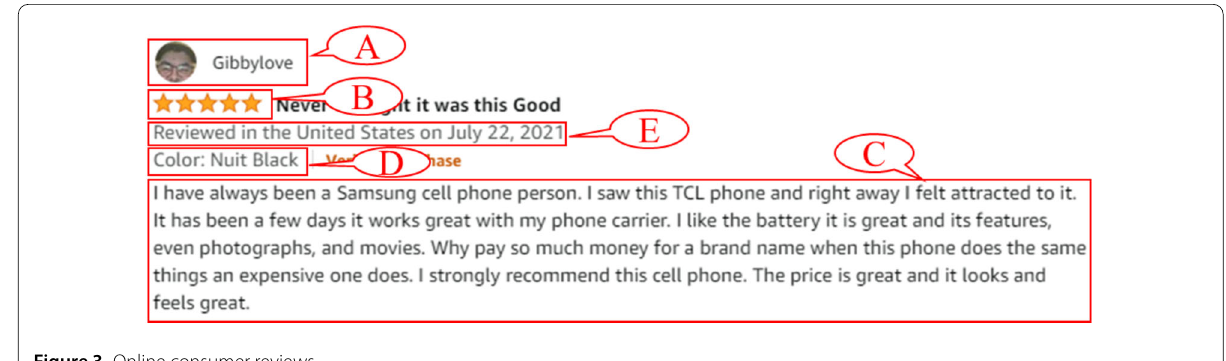
Figure 3 Online consumer reviews